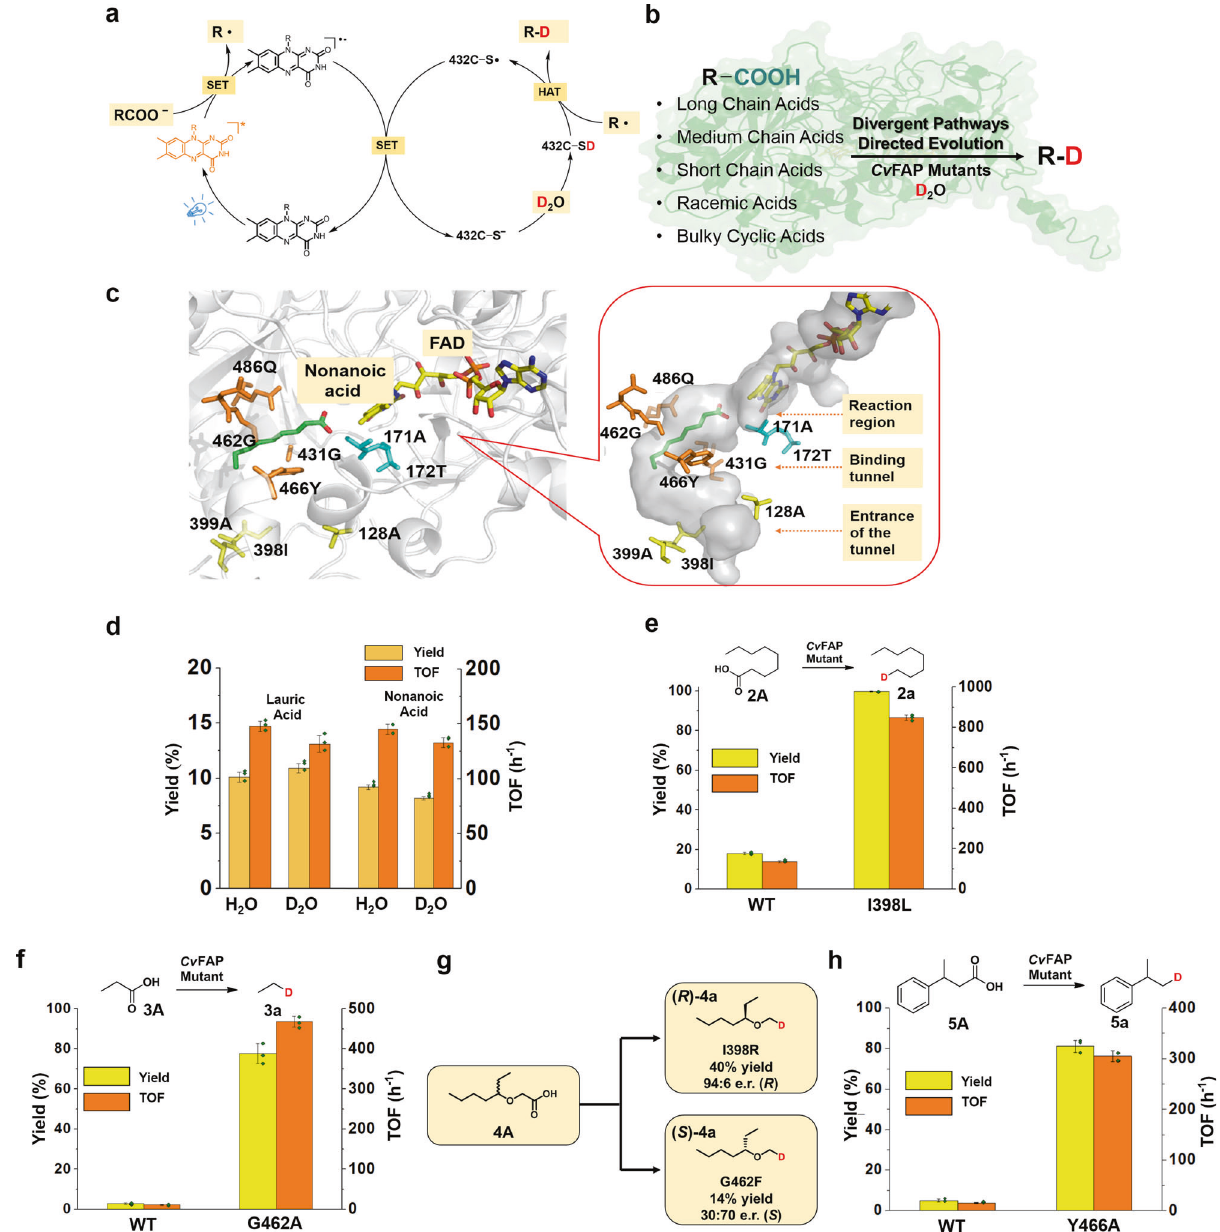
Fig. 1 Design of Cv FAP-catalyzed decarboxylative deuteration and divergent directed evolution of Cv FAP. a Proposed mechanism of Cv FAP-catalyzed decarboxylative deuteration. b Design of divergent directed evolution of Cv FAP toward various substrates. c Docking result with nonanoic acid (green) and selected hot positions for protein engineering (PDB:5NCC) 49 , FAD ( fl avin adenine dinucleotide) and some representative residues located at the entrance of the substrate pocket (yellow), binding region (orange) and reaction region (cyan) are represented by sticks with different colors. d The in fl uence of kinetic isotope effect on the reaction activity. e The comparison of yields and TOF between WT- Cv FAP and the best mutant (I398L) for the medium chain acid. f The comparison of yields and TOF between WT- Cv FAP and the best mutant (G462A) for the short chain acid. g The enantiodivergent decarboxylative deuteration catalyzed by I398R and G462F mutants, respectively. h The comparison of yields and TOF between WT- Cv FAP and the best mutant (Y466A) for bulky cyclic acid. Error bars represent the mean ± SD of three independent experiments. Source data are provided as a Source Data fi